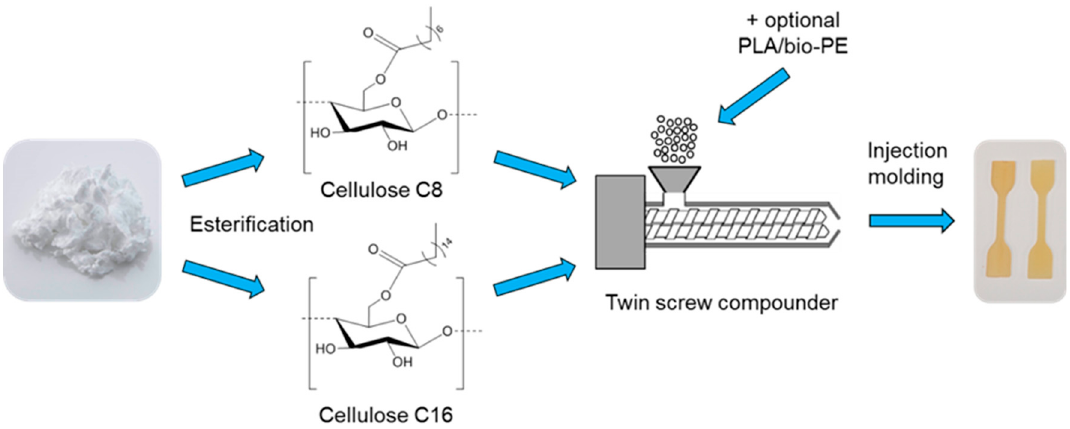
Figure 1. Schematic illustration of this research. PLA: poly(lactic acid); PE: polyethylene.